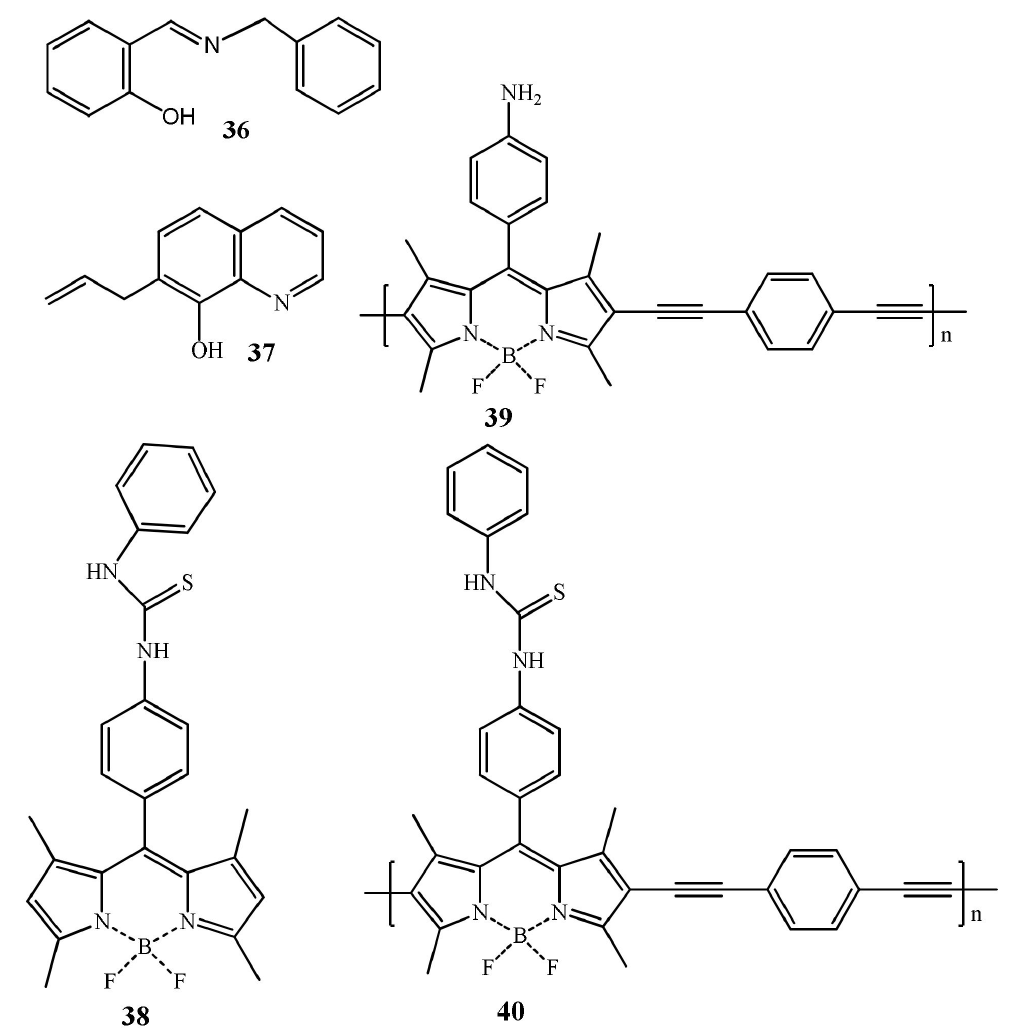
Figure 13. Molecular structures of the sensors 36 to 40